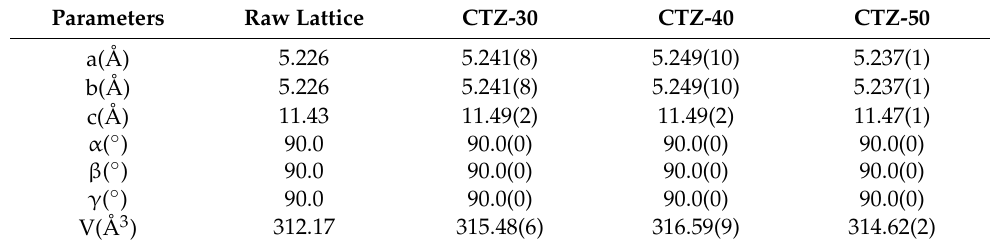
Table 3. Cell parameters obtained by refining the powellite phase in the obtained glass-ceramics. Numbers presented in parentheses are error standard deviations of the corresponding parameters.